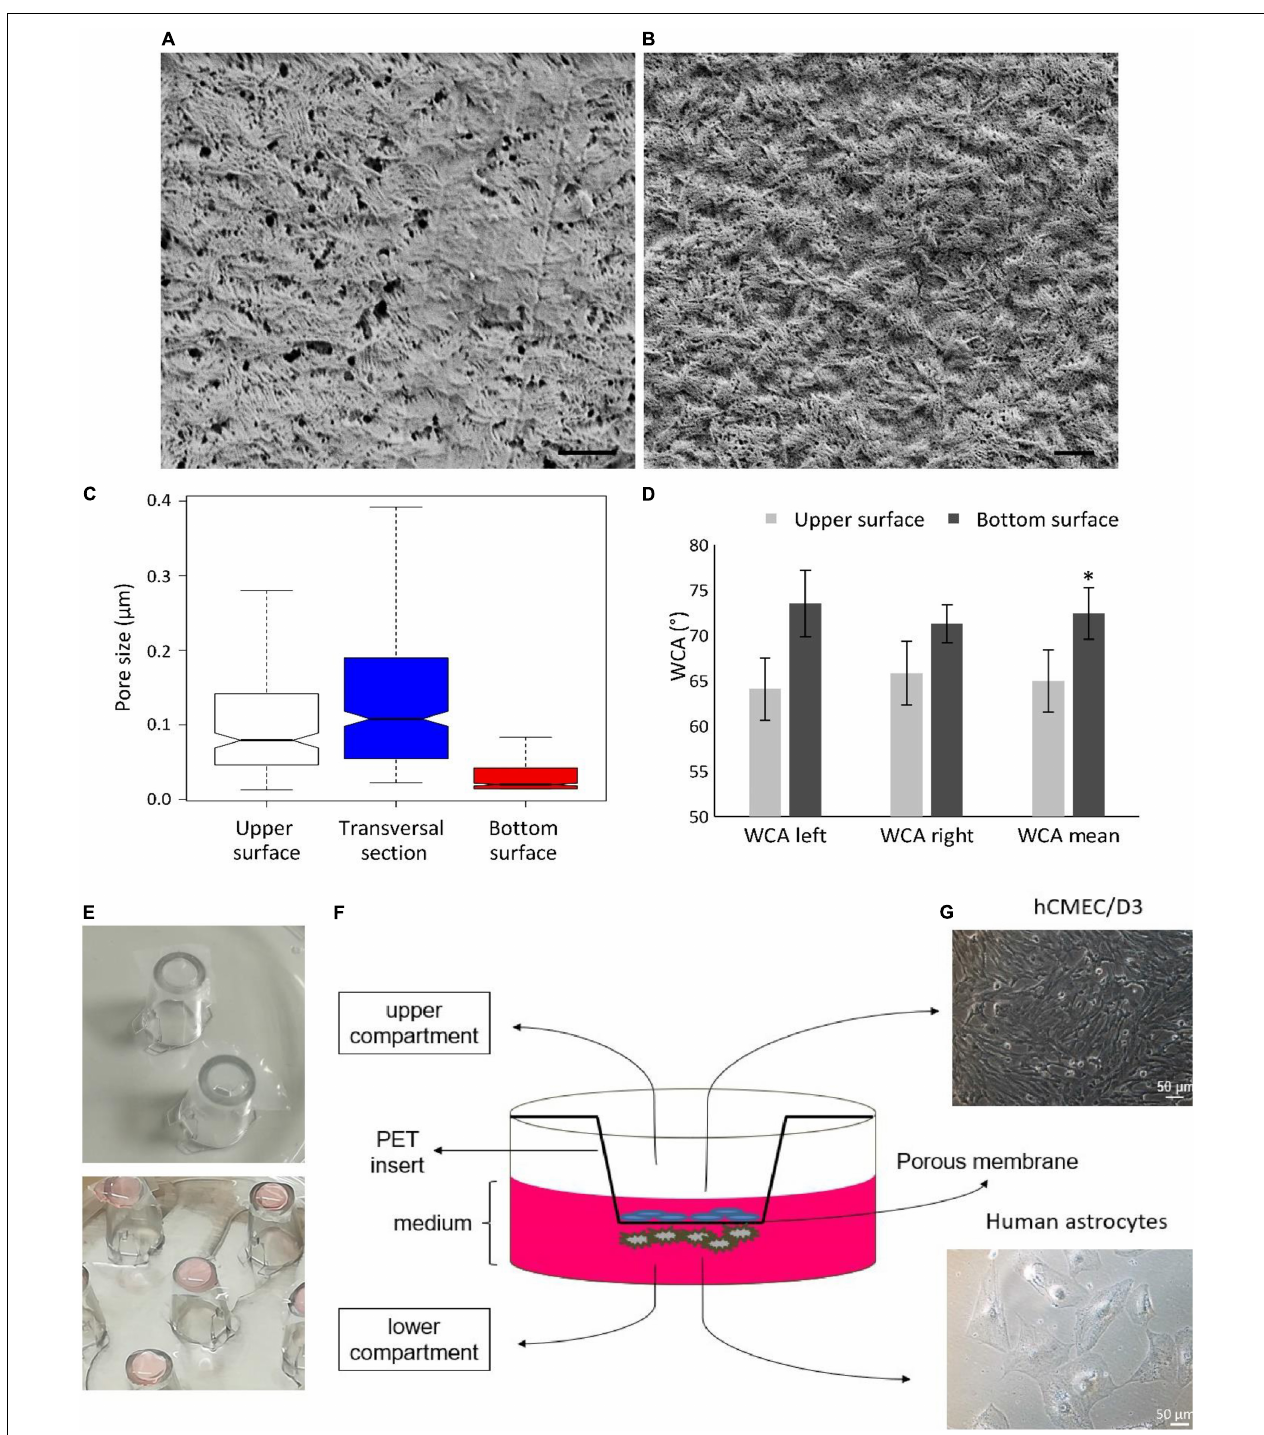
FIGURE 2 | Characterization of the CA membranes fabricated by using 25% H 2 O + 75% EtOH non-solvent and preparation of the BBB model. Representative SEM scans of the (A) upper and (B) bottom surfaces. Scale bar: 1 µ m. (C) Pore size distributions of the upper, bottom, and transversal surfaces. (D) Water contact angles (WCA) of the bottom and upper surfaces; WCA was measured on the left and right interfaces between the water drop and the substrate; the mean WCA value was calculated from the left and right angles. (E) Representative images showing the insert preparation with CA membranes (top), and the cell seeding of human astrocytes on the bottom surface of the membranes (bottom). (F) Scheme of the multicellular in vitro BBB model with (G) hCMEC/D3 human cerebral microvascular endothelial cells seeded at high confluence on the upper surface (top) and human astrocytes on the bottom surface of the CA membranes. * p < 0.05.